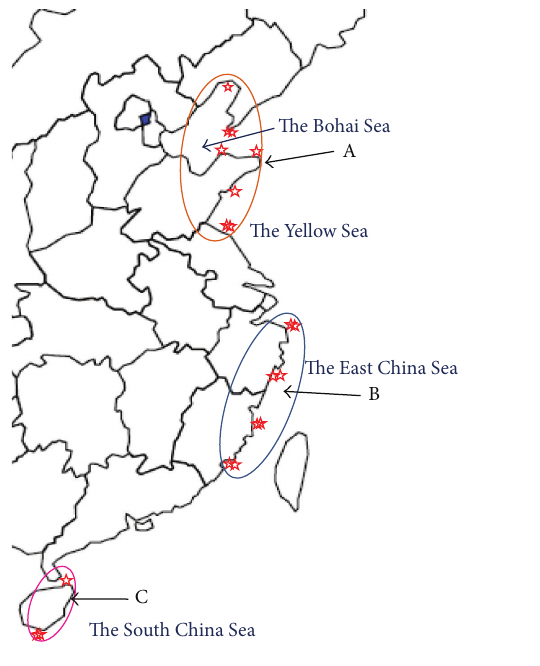
Figure 4: The regional distribution of Thais clavigera